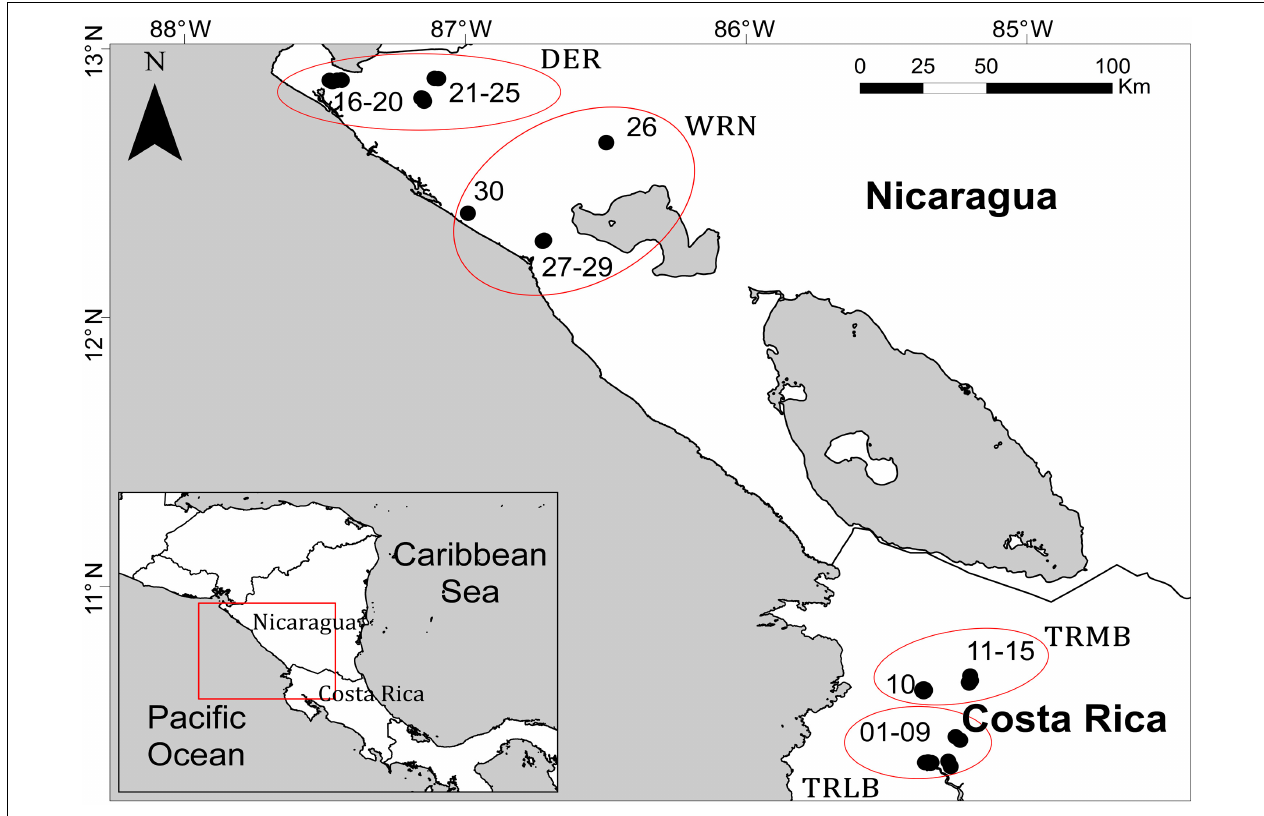
FIGURE 1 | Map of the study area with the location of the studied ponds, grouped in four main clusters: DER (Delta of Estero Real), WRN (Western Region of Nicaragua), TRMB (Tempisque River Medium Basin), and TRLB (Tempisque River Low Basin). Based on Figure 1 in Sasa et al. (2015).